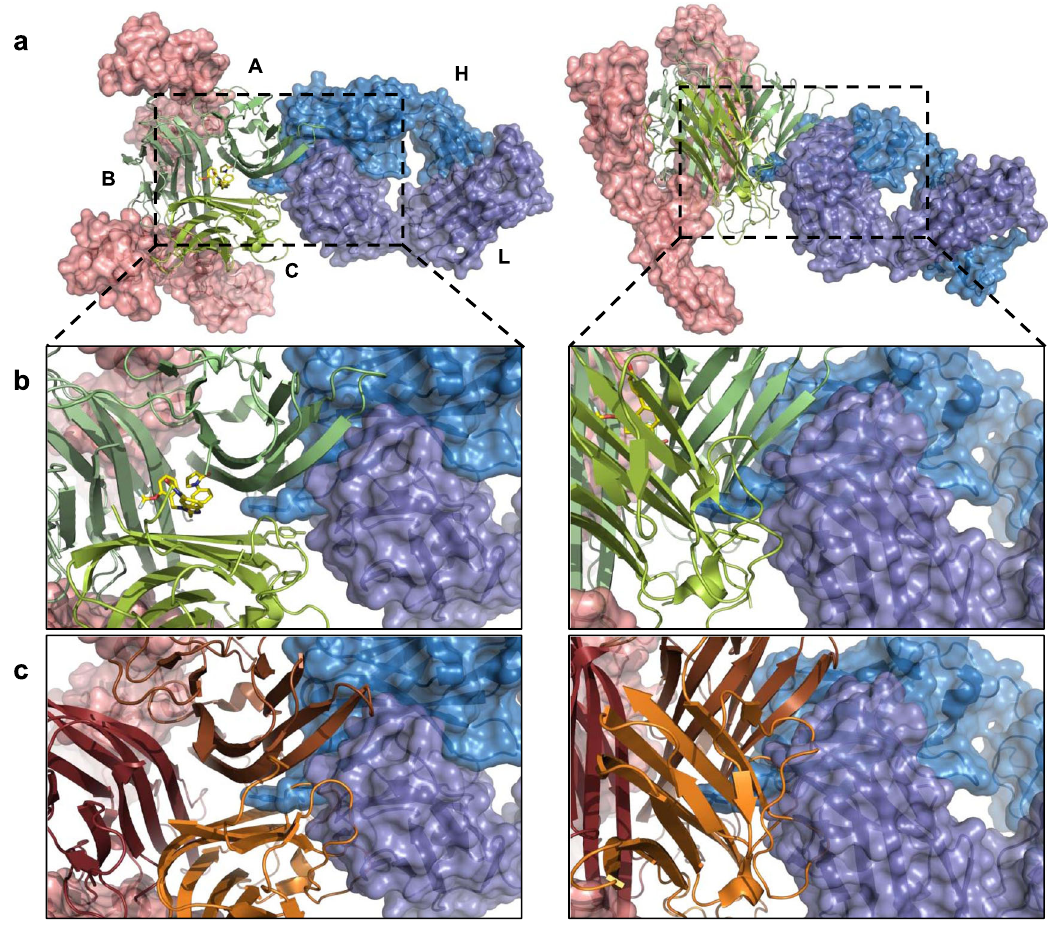
Fig. 3 Structure of CA1974 Fab-human TNF-UCB-8733-TNFR1 complex. a Trimeric human TNF (green ribbons, monomers assigned A, B, & C) with UCB- 8733 bound (yellow sticks), in complex with CA1974 Fab (blue surface rendered) and two copies of human TNFR1 (pink surface rendered), viewed from the top and side (left and right images respectively). b Detailed view of the CA1974 Fab-human TNF (with UCB-8733 bound) interface viewed from the top and side (left and right images respectively). c Detailed view of a structural model where compound-bound human TNF has been replaced by apo human TNF (brown ribbons) viewed from the top and side (left and right images respectively). This highlights side-chain clashes between the CA1974 Fab and symmetric apo